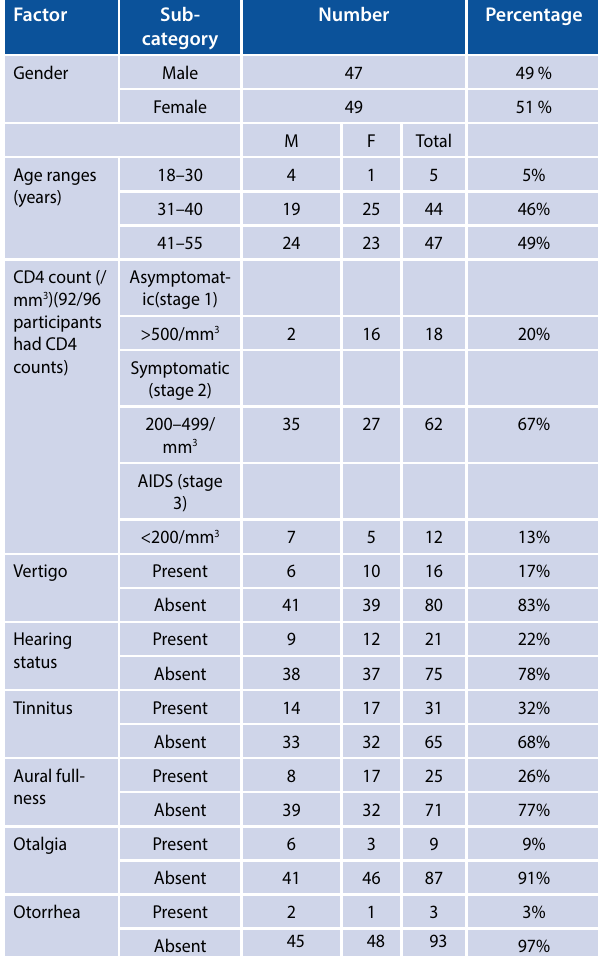
Table 1: Demographics of the participants ( N = 96)